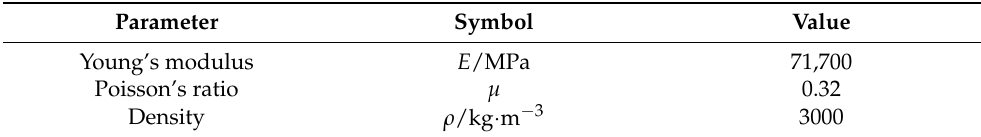
Table 2. Material properties of Al 7075-T651